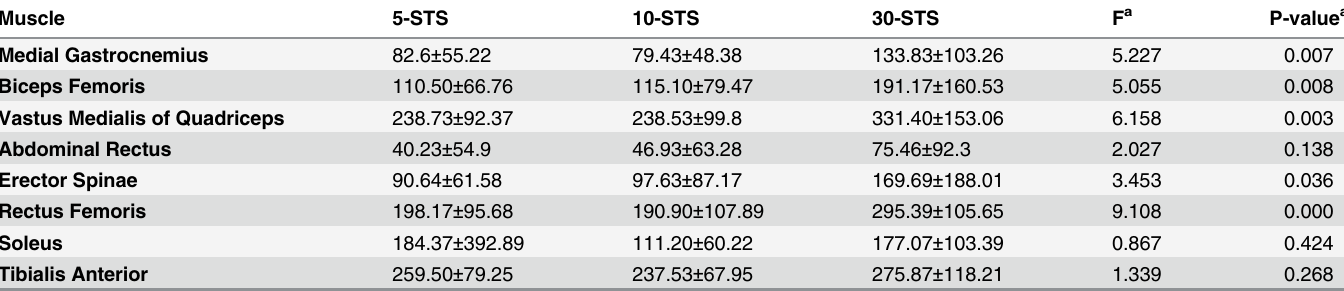
Table 3. Muscle activation ( μ V) during STS test variants (mean ± SD) in total sample (n = 30) and ANOVA (f,p) test. Muscle